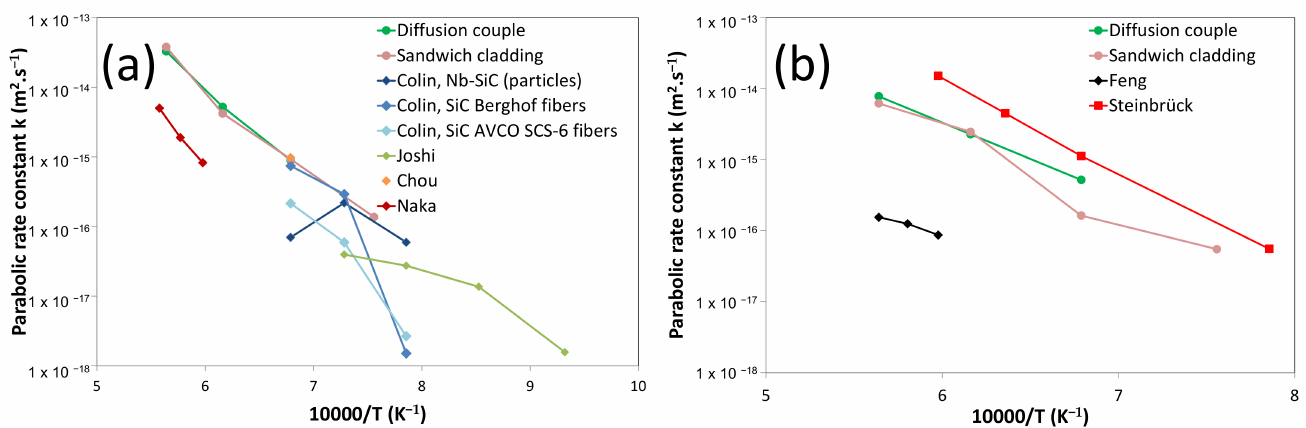
Figure 16. Parabolic growth constants ( k ) as a function of the inverse of the temperature in comparison with literature data in the Nb/SiC ( a ) and Ta/SiC ( b )